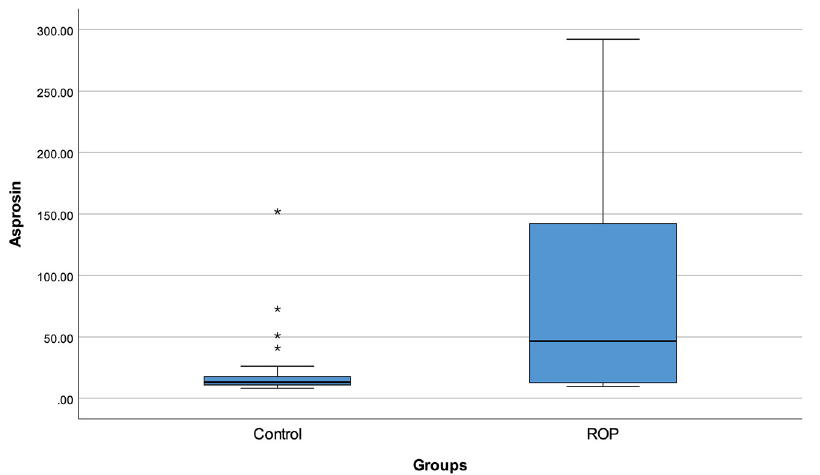
Figure1: Serumasprosinlevelwith regardto groups.